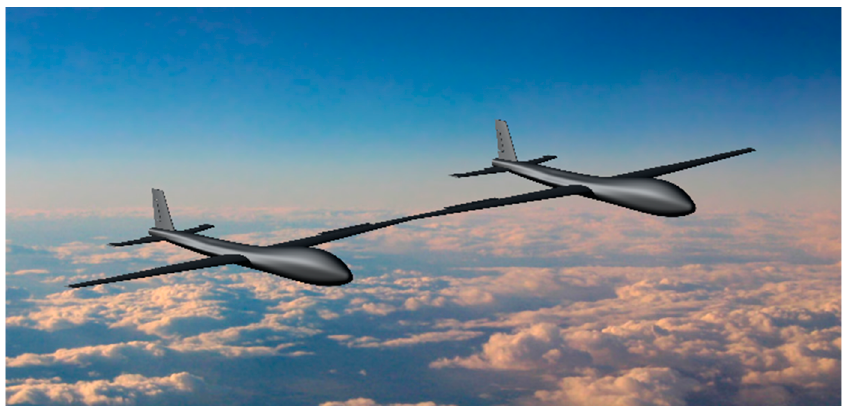
Figure 1. Wingtip-jointed compound aircraft system.